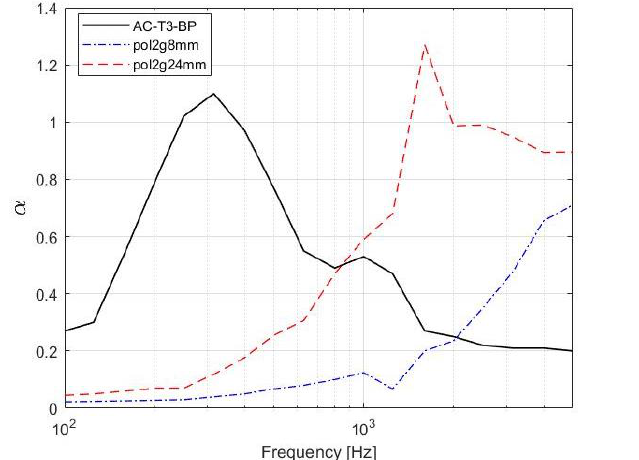
Figure 12. Comparison of the sound absorption coefficient α measured for panel AC-T3-BP and that measured in the impedance tube for polyester 0.2 g/cm 3 in density [51]. Sample pol2g8mm is 8 mm thick, while pol2g24m is 24 mm